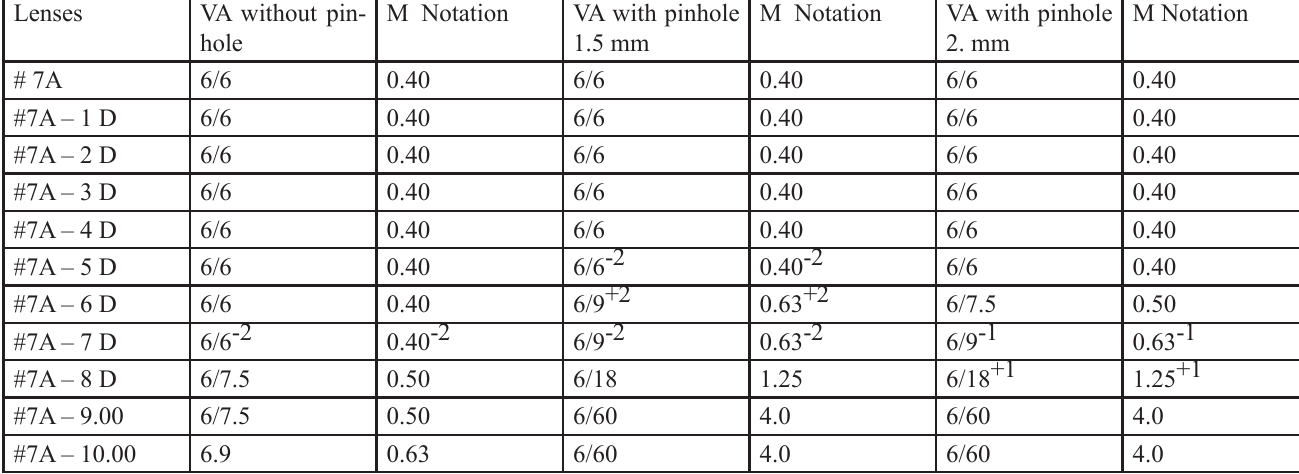
Table 4. Effect of negative lenses on VA for Subject 1 viewing a Lighthouse near acuity chart at 40 cm without a pinhole and through a pinhole with a 1.5 mm and 2 mm diameter respectively while the target was illuminated at 460 lux.